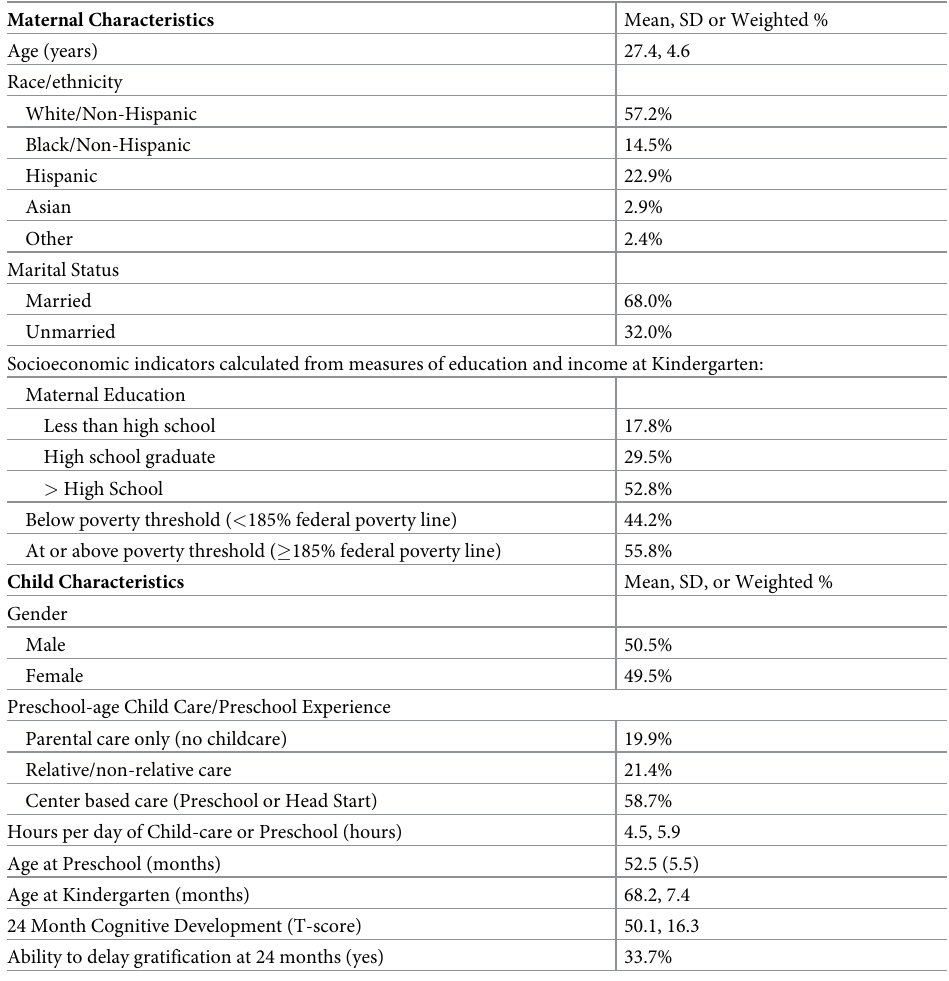
Table 1. Maternal and child